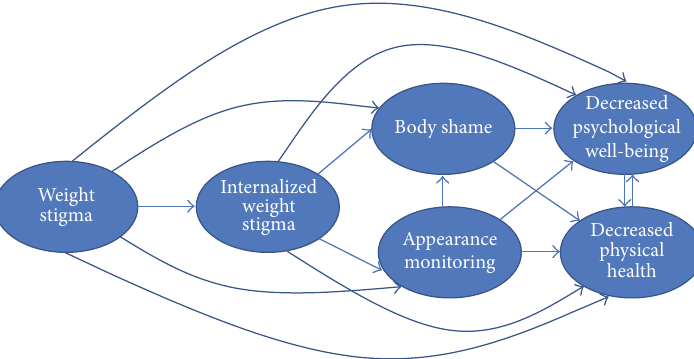
Figure 2: Theoretical model of weight stigma and its associated